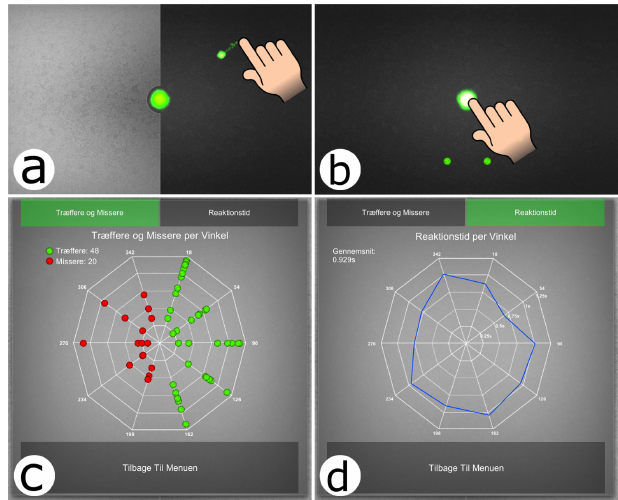
Figure 1. WAM design (left, top) in which a hit target flings back to the center, b) tap on the center button makes multiple targets appear c) number and spatial distribution of hits and misses d) hit delays per axis on which the targets